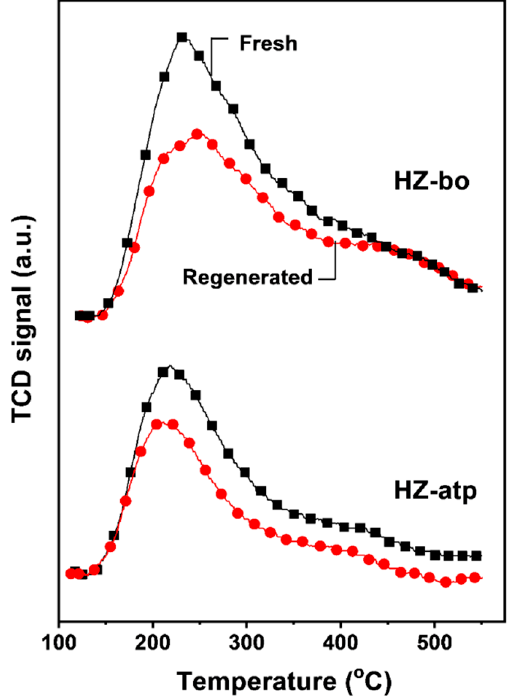
Figure 9. NH3-TPD profiles of fresh (black) and regenerated (red) zeolite extrudates.